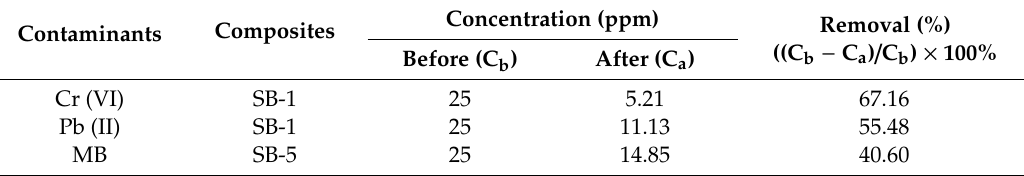
Table 4. Removal % of heavy metals and dye from standard solution by the best selected